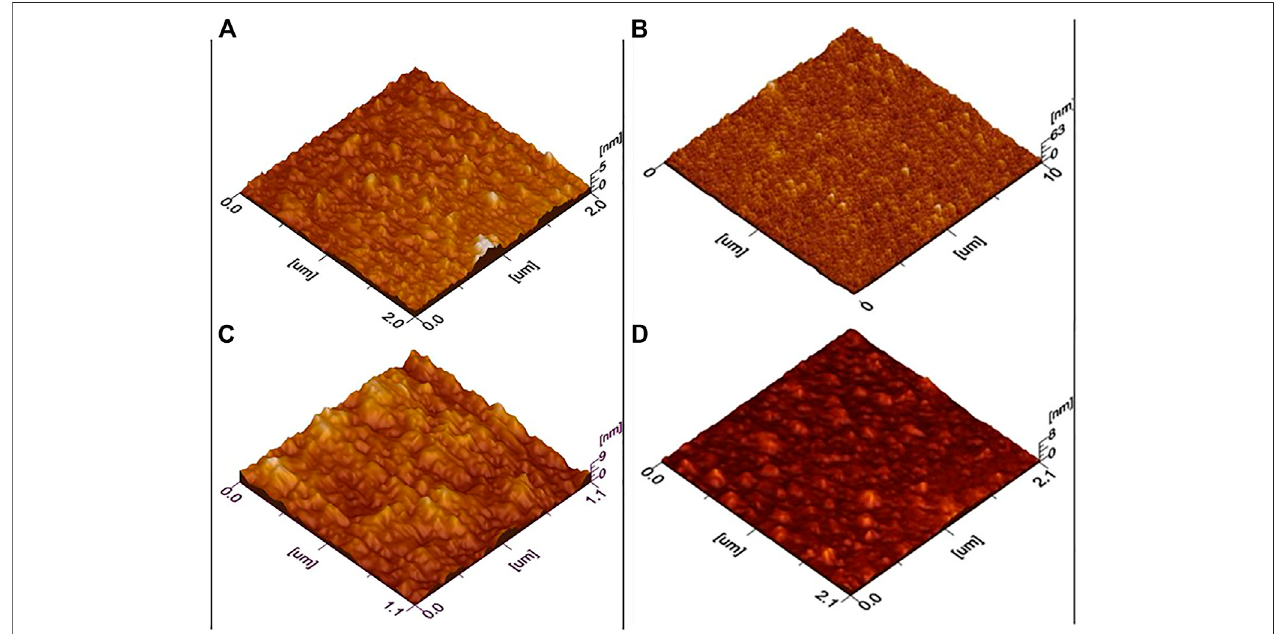
FIGURE 3 | Three-dimensional AFM images of (A) ZnO, (B) 1% Al, (C) 2% Al, and (D) 3% Al.